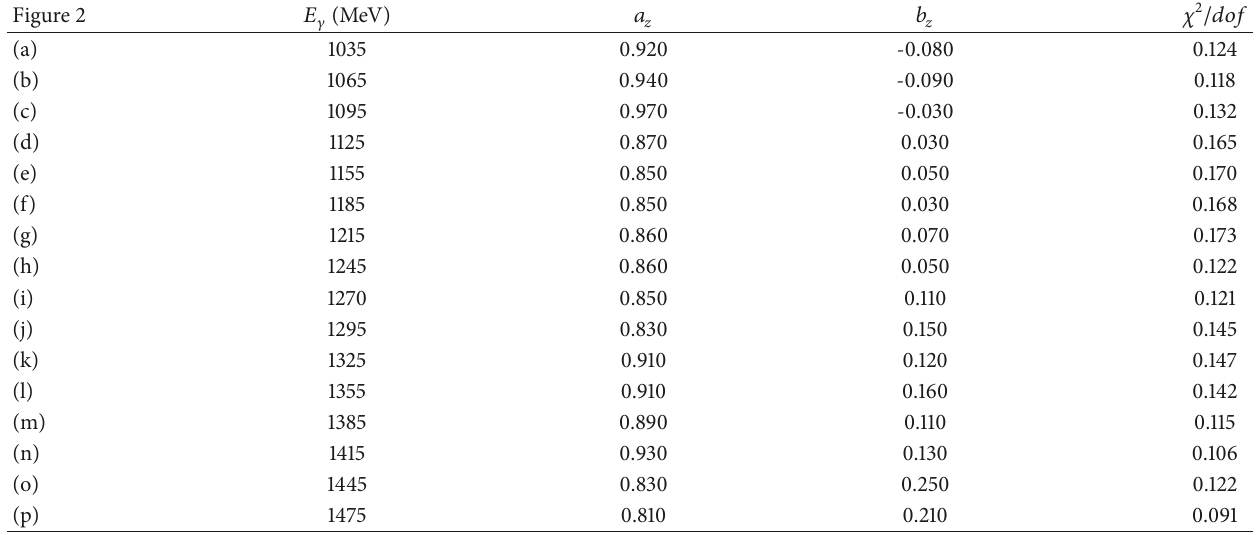
Figure 3: Same as Figure 1, but showing angular distributions for different bins of incident photon energy 1505 MeV ≤ E 𝛾 ≤ 1835MeV. Table 2: Values of 𝑎 𝑧 and 𝑏 𝑧 taken in Figure 2 model results.